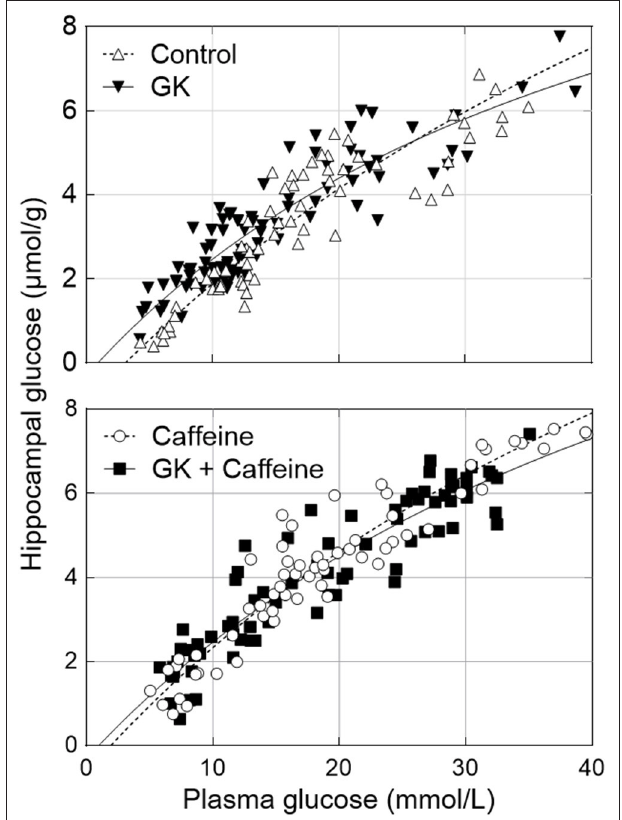
FIGURE 4 | Relationship between hippocampal and plasma glucose concentrations in control and GK rats treated or not with caffeine (1 g/L). Data corresponds to steady-state hippocampal glucose levels determined from 1 H NMR spectra measured during 40min after plasma glucose was stable for at least 15min. The kinetic parameters of glucose transport estimated from these datasets are presented in Table 2 and all measurements from n = 6–8 animals per group were pooled together.